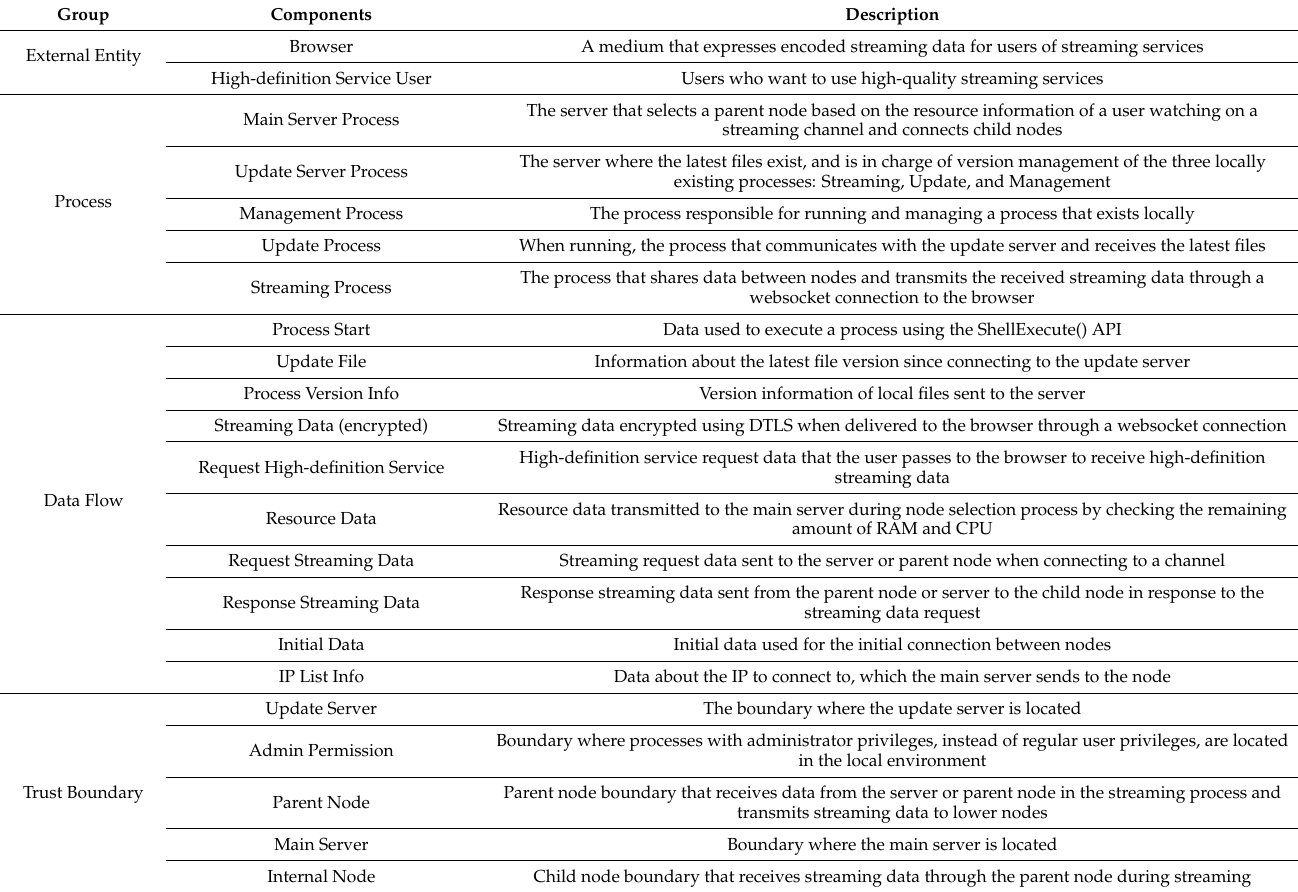
Table A4. Components of a tree-structure-based grid computing system.